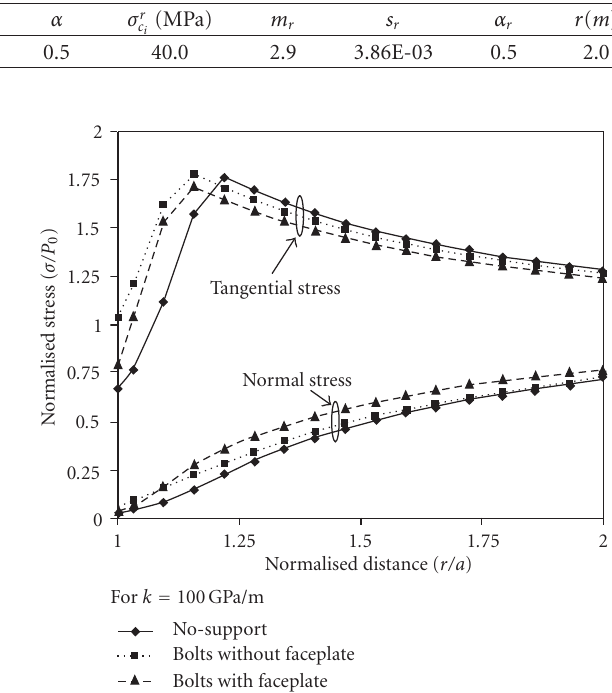
Figure 10: Distributions of stresses in rock mass around the tunnel boundary.